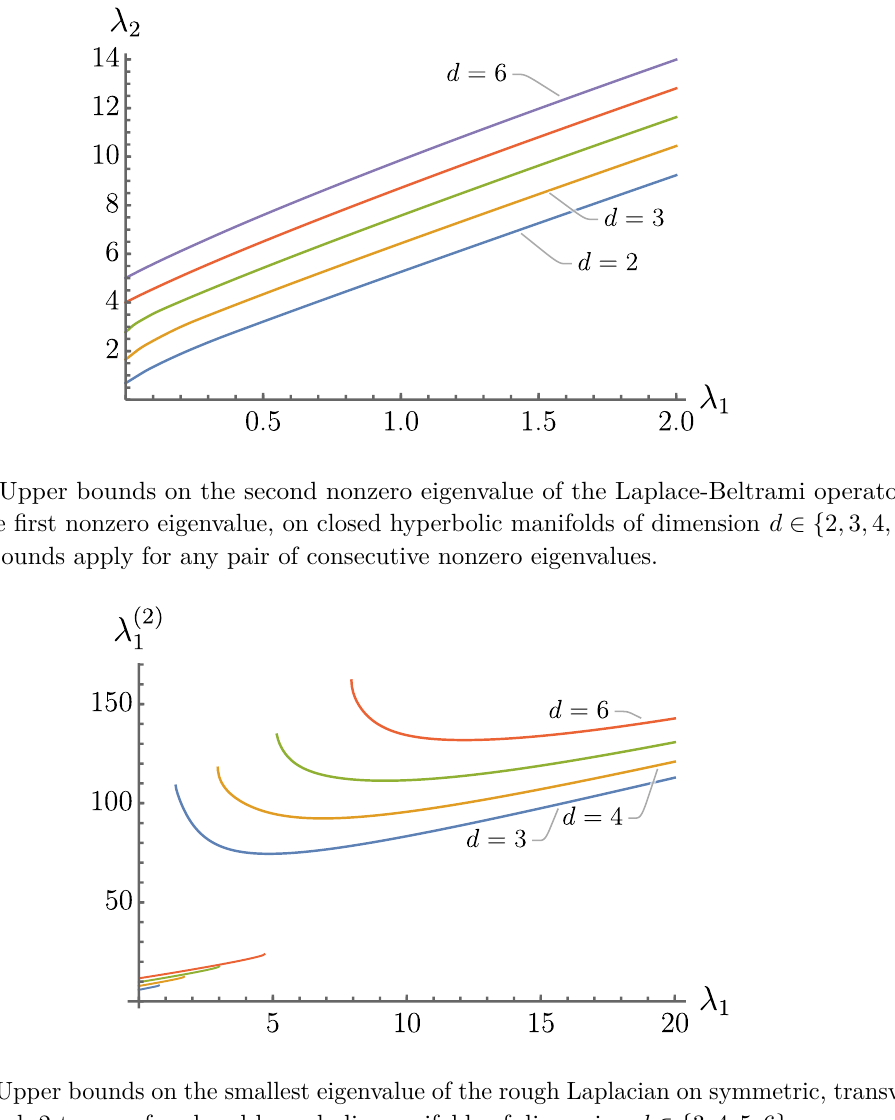
Figure 6 . Upper bounds on the smallest eigenvalue of the rough Laplacian on symmetric, transverse- traceless, rank- 2 tensors for closed hyperbolic manifolds of dimension d ∈ { 3 , 4 , 5 , 6 }